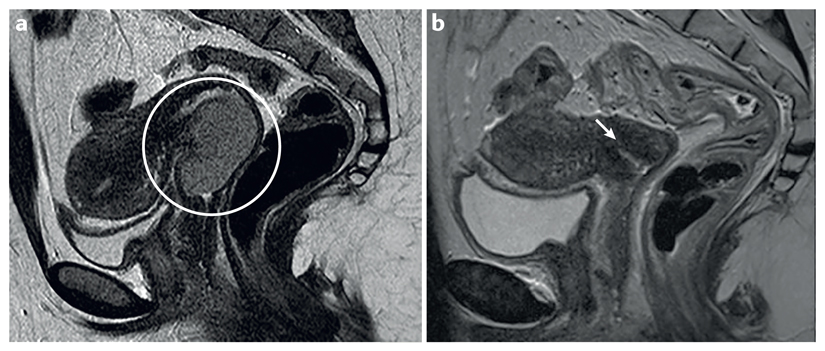
a | A patient with cervical cancer (T3b N0 M0) had a bulky primary tumour at baseline, but b | showed a complete response and reconstitution of the cervix following therapy with chemoradiation.